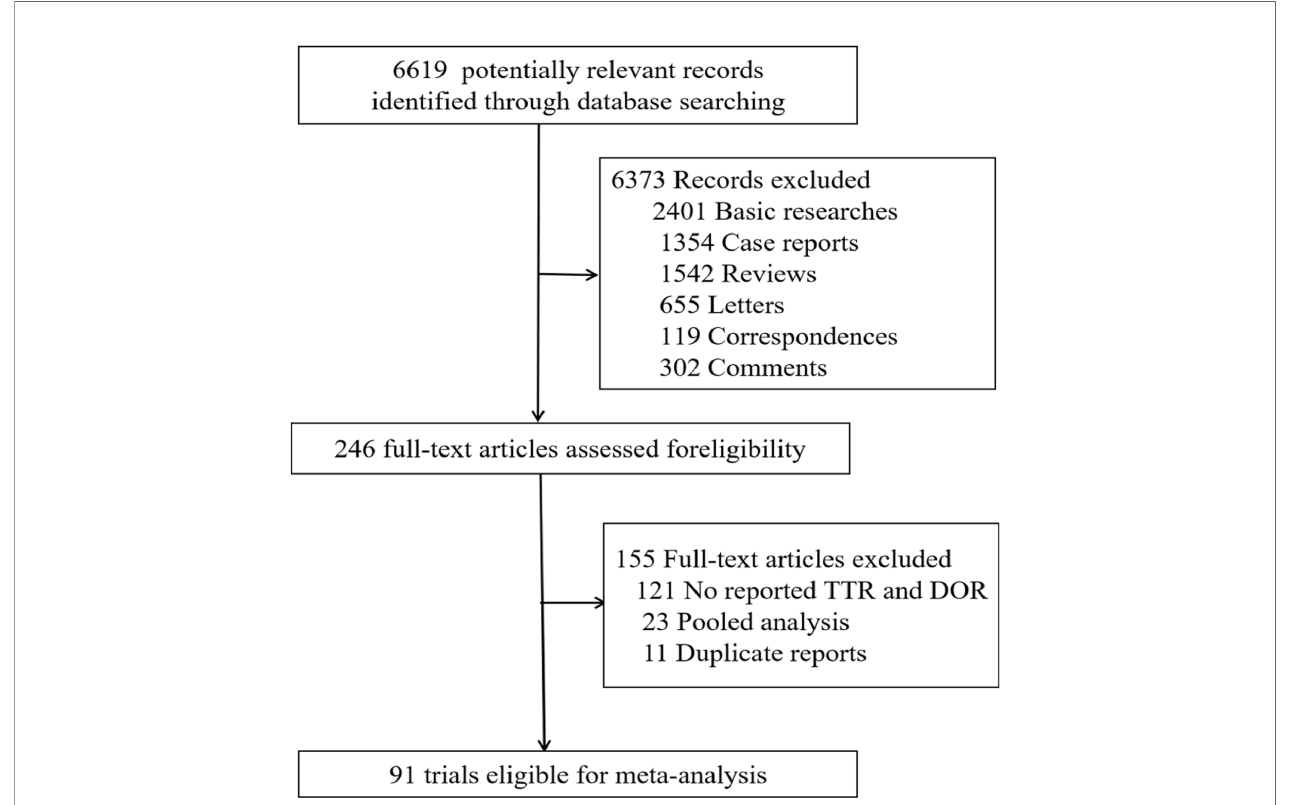
FIGURE 1 | Flow diagram of the literature search and trial selection